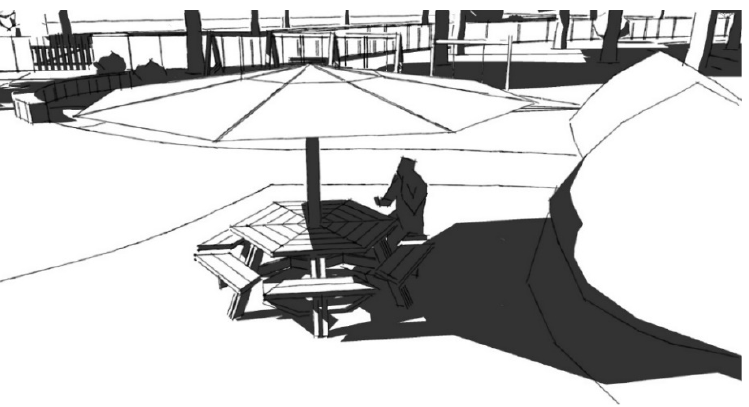
Figure 19. Picnic table at Beaton Park partially shaded by an umbrella at midday on the winter solstice.